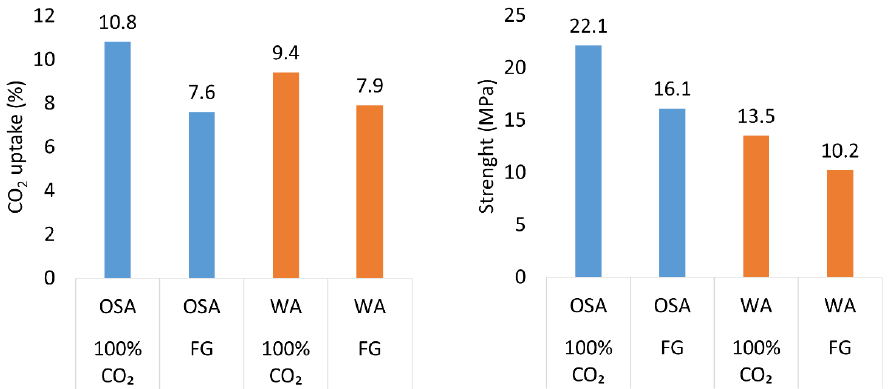
Figure 10. CO 2 uptake ( left ) and compressive strength ( right ) values at different CO 2 concentrations (10 bar, 25 °C, 150 kgf/cm 2 ) (Average values obtained from min. 4 samples (std. deviation < 3%)).